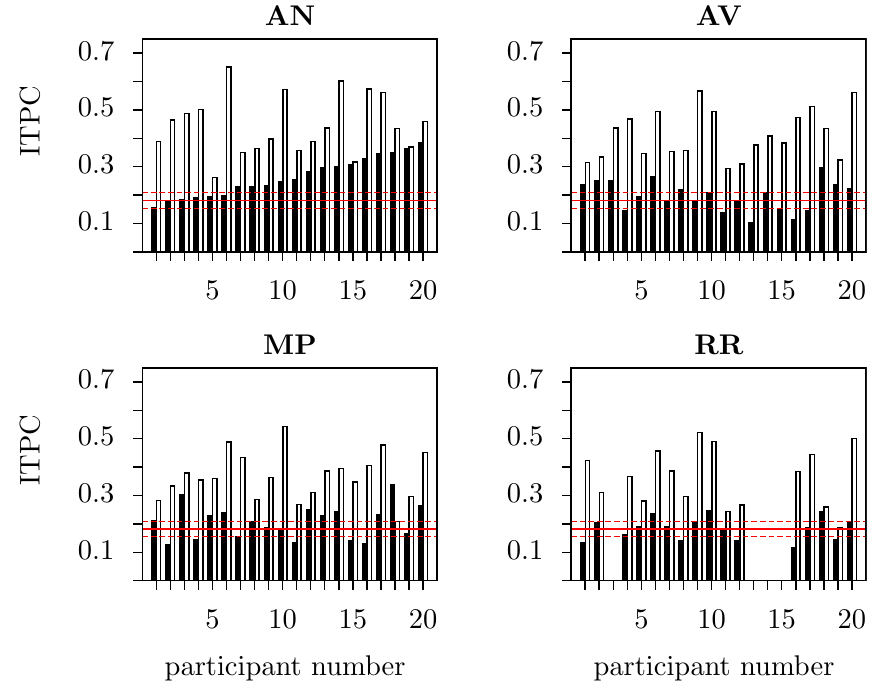
Figure 4. ITPC responses from individual participants at the phrase rate (3.125 Hz; filled bars) and the syllable rate (1.5625 Hz; unfilled bars) in each of the four conditions (AN, AV, MP, RR). For the AN, AV and MP conditions, values of the ITPC at each frequency of interest are displayed for each of the 20 participants, for RR, for the 16 participants. Participants one to 20 are ordered in accordance to their ITPC at the phrase frequency in the AN condition, in increasing order from left to right. Red horizontal lines indicate the mean ITPC value for random phases along with the corresponding significance thresholds ( p < 0.05 ). These values are the same for both frequencies and so any ITPC that is above the upper red line is significantly higher than chance